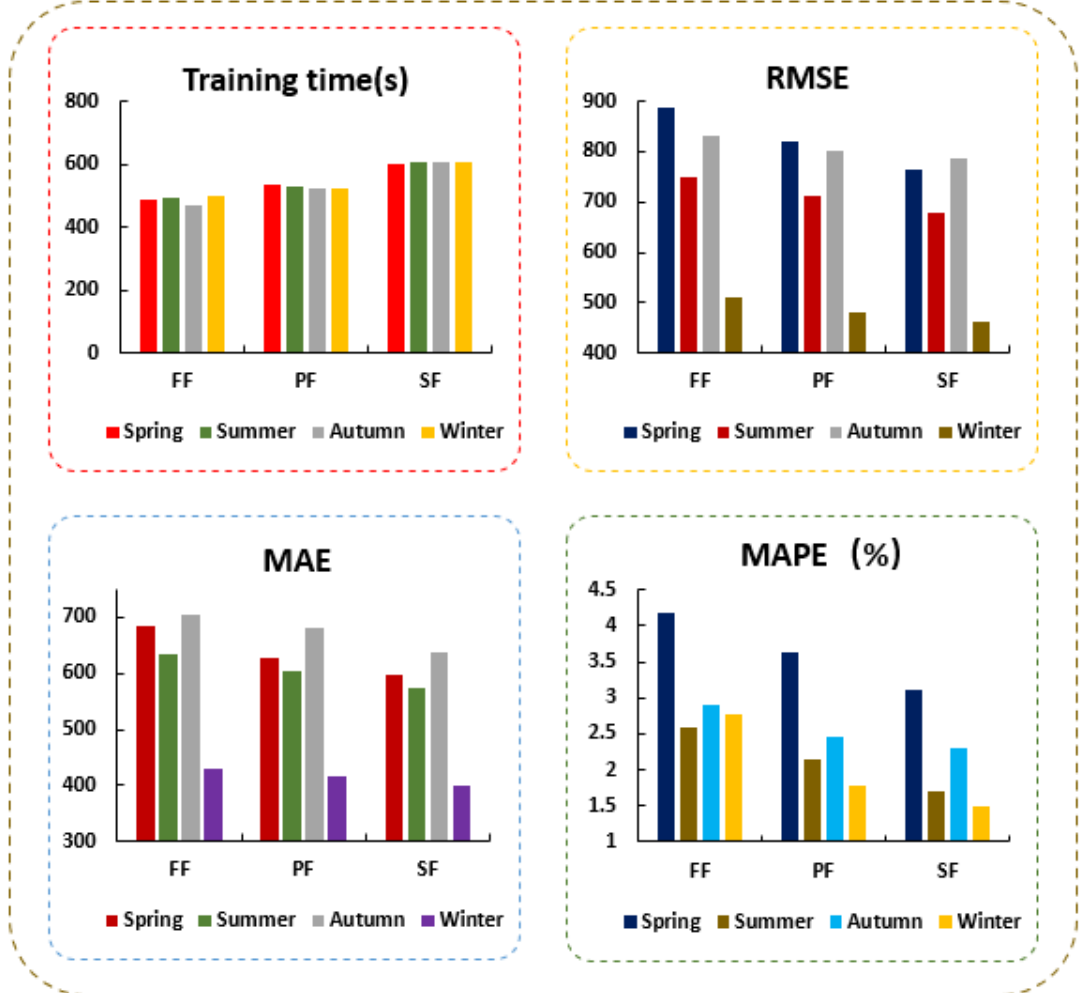
Figure 7. Prediction results of different feature selection methods.